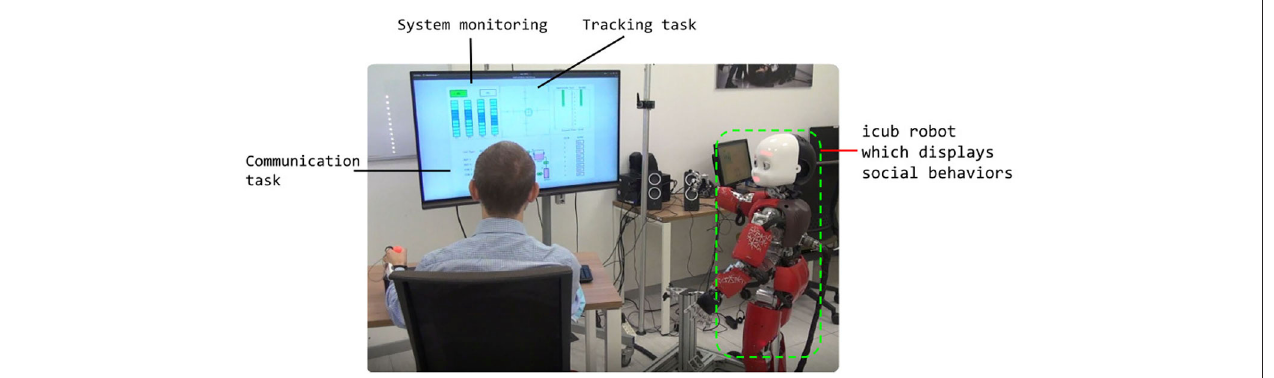
FIGURE 1 | The experimental set up: a participant is seated in front of a computer monitor which displays the different subtasks included in MATB. The participant executes the different duties via keyboard or joystick and their face and upper body are recorded using a web camera. Depending on the condition, the icub robot is present throughout the course of the experiment. The robot’s face expressions are controlled via LEDs, other body movements are predefined (Adapted from Aoki et al., 2022).